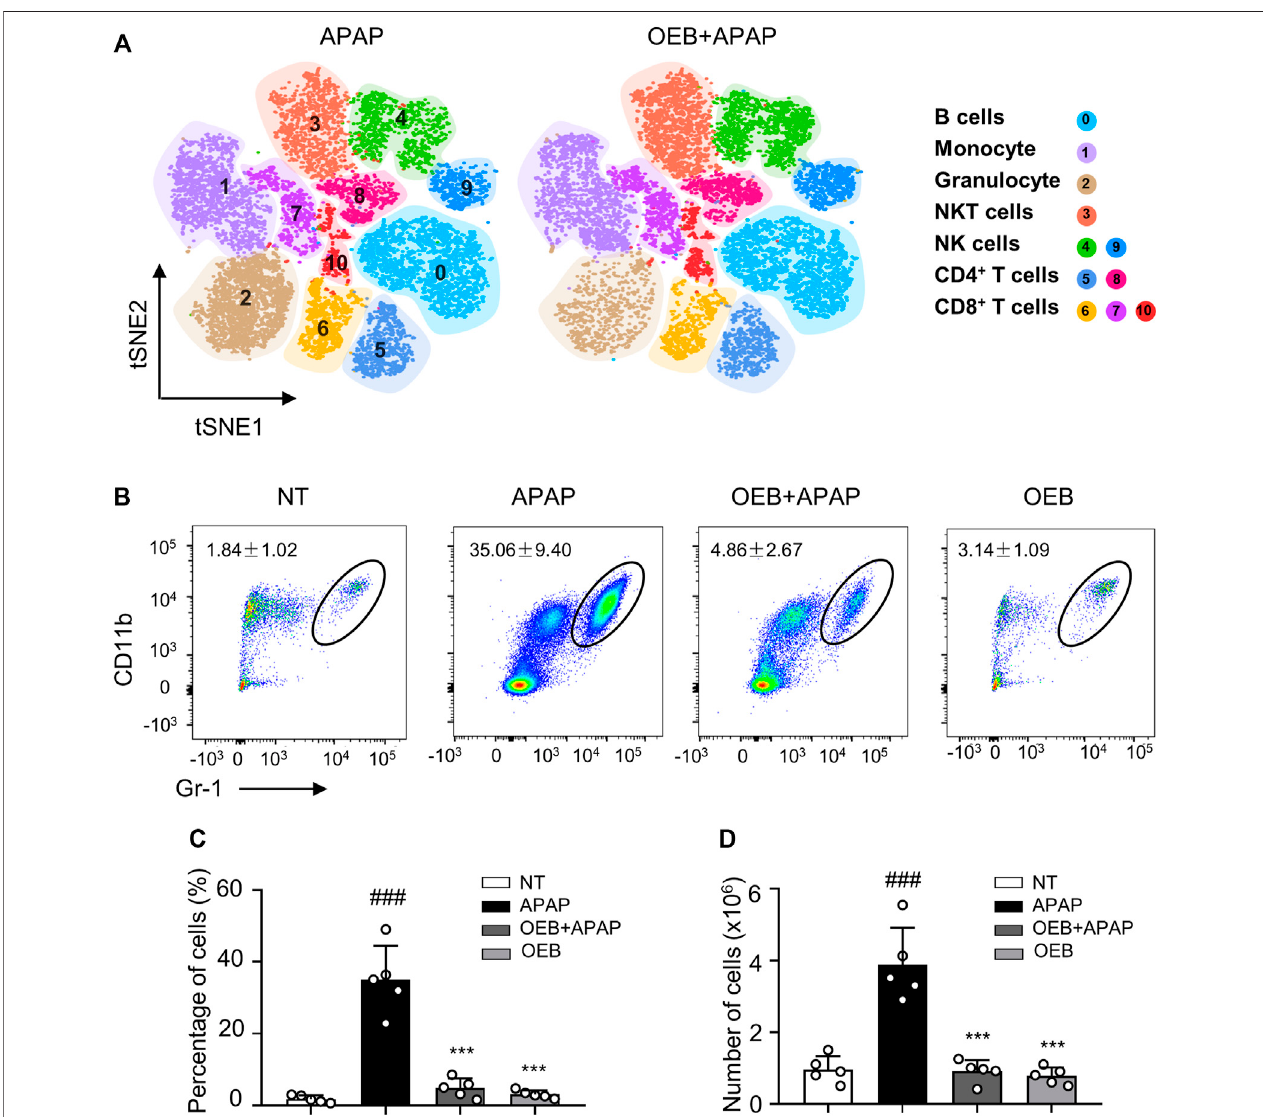
FIGURE 5 | OEB reduced APAP-induced hepatotoxicity by affecting immune cells in the liver. (A) Merged t-SNE plots of fl ow cytometry data from liver samples of APAP ( n = 3) and OEB + APAP ( n = 3) groups. (B) Representative fl ow cytometry data for hepatic CD11b + Gr-1 high neutrophil in fi ltration in the liver of APAP and OEB